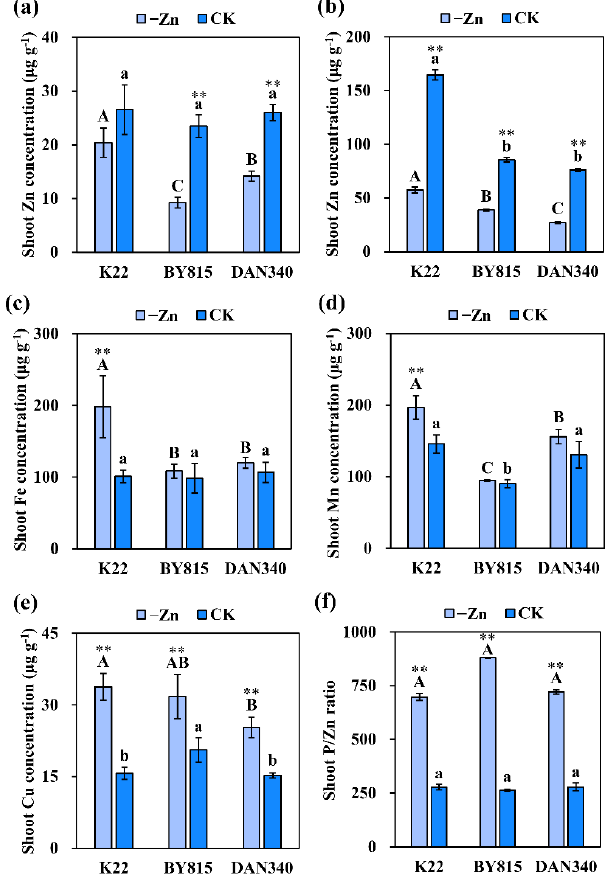
Figure 2. Shoot ( a ) and root ( b ) concentrations (μg g −1 ) of Zn, shoot concentrations of Fe ( c ), Mn ( d ), and Cu ( e ), and shoot P/Zn ratios ( f ) of parent plants (K22, BY815, and DAN340) hydroponically grown under Zn- deficient (0.3 μmol L −1 Zn-EDTA) and Zn- sufficient (10 μmol L −1 Zn-EDTA) condi- tions for 21 days after transplanting. Different uppercase (lowercase) letters indicate significant dif- ferences among K22, BY815, and DAN340 in the -Zn (CK) treatments at p ˂ 0.05. ** indicates signif- icant differences between the -Zn and CK treatments at p ˂ 0.01.